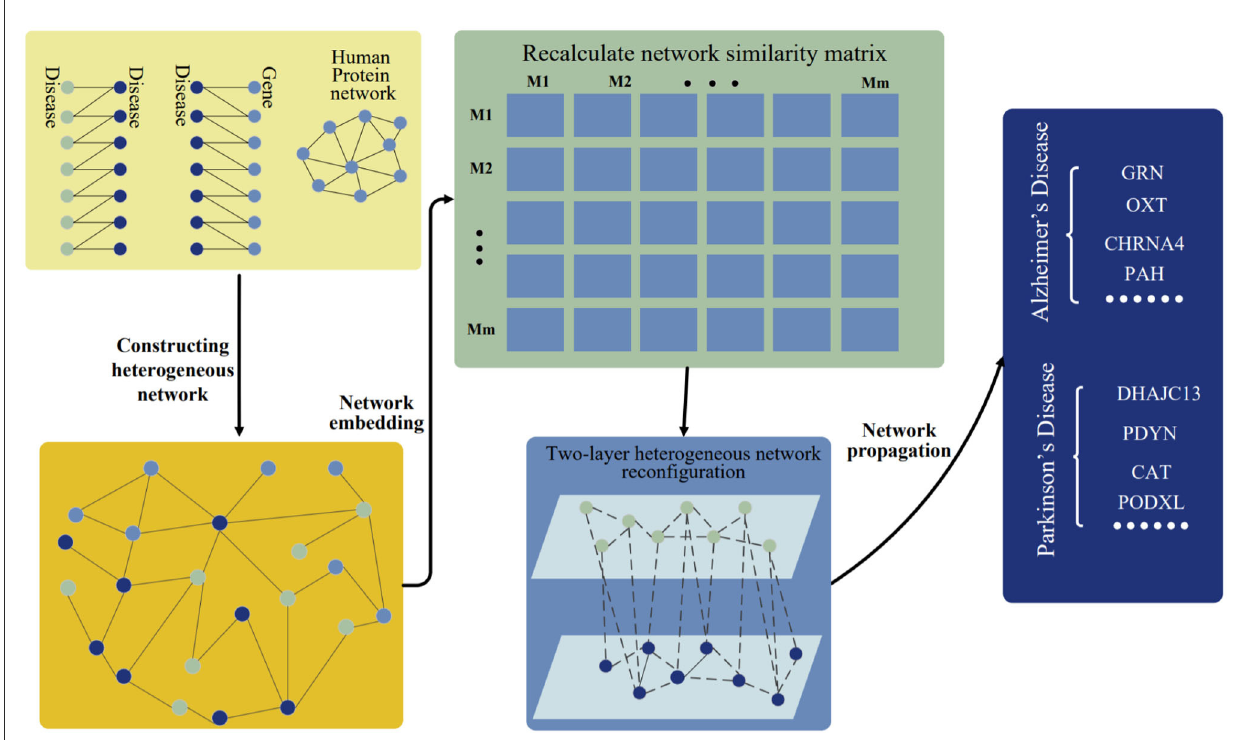
FIGURE1 Workflow of PSNE. The disease-disease associations, disease-gene associations, and human protein network are connected together and constructed as a heterogeneous network. The network embedding algorithm is used to realize the low-dimensional vector representation of the network and then a new two-layer heterogeneous network of diseases and genes is constructed. Finally, the network propagation algorithm is used to predict the pathogenic genes.